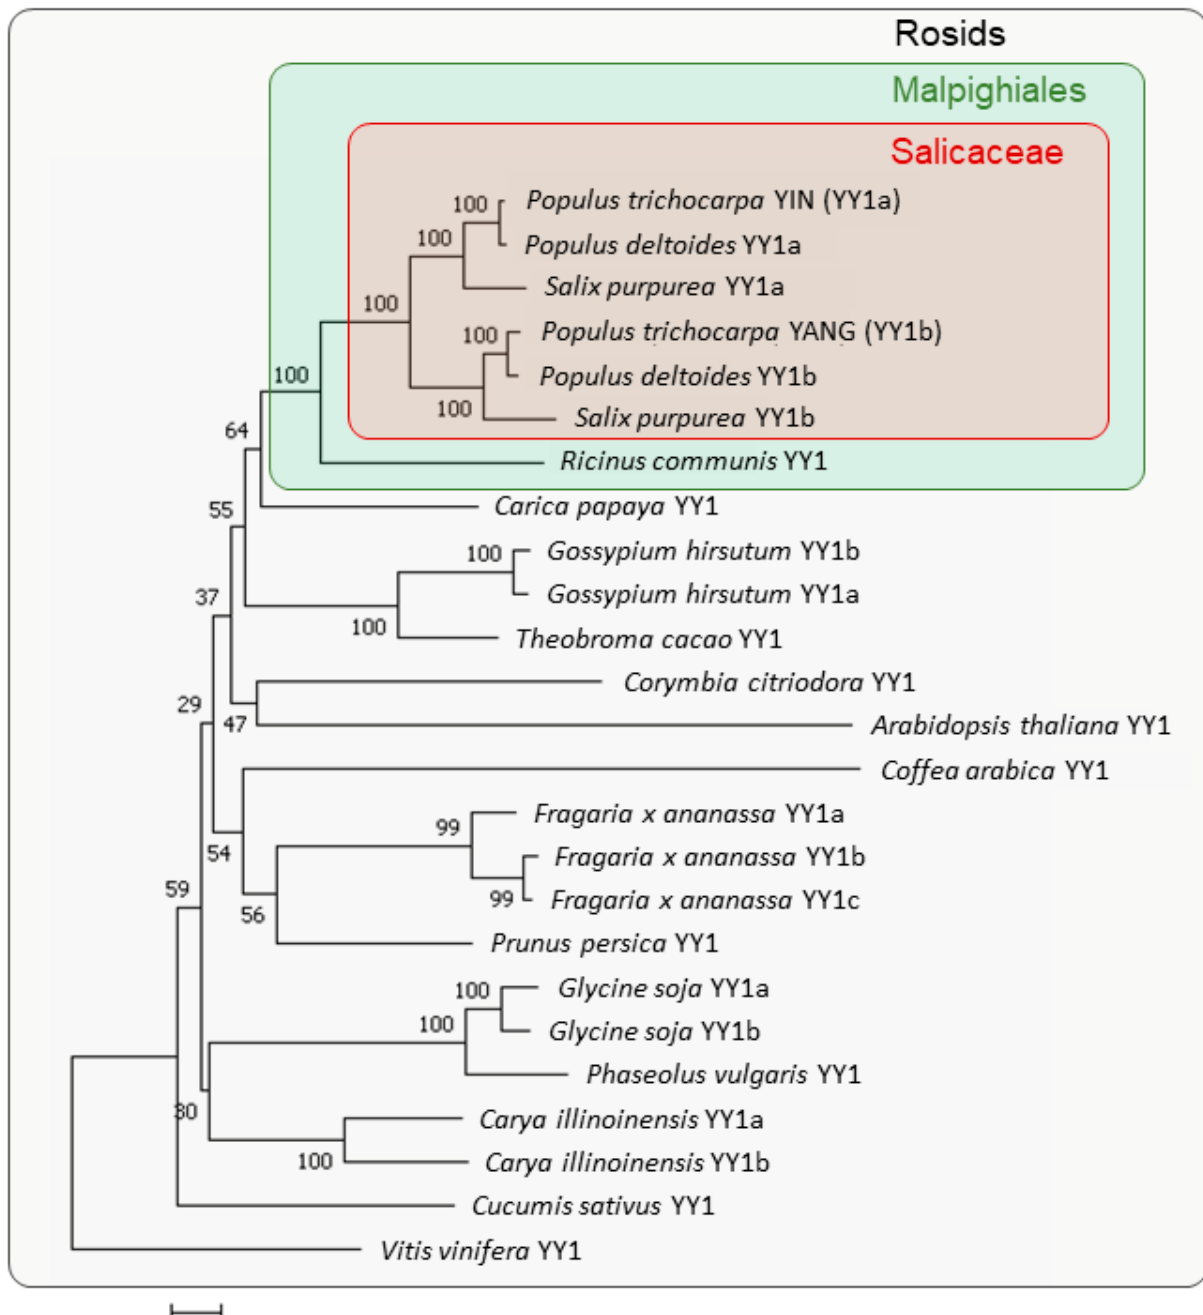
Figure 1. Phylogenetic relationship of YY1 proteins from different plant species of the Rosids clade. The phylogenetic tree constructed with 25 YY1 genes from 17 different species. The Salicaceae family is marked by a red box, while the Malpighiales clade is marked by a green box. Bootstrap support values are given at the nodes. The phylogenetic analyses were conducted with MEGA 7 using the neighbor-joining (NJ) method and 1000 repetitions of bootstrap tests. All YY1 Sequence were obtained from The Phytozome (https://phytozome-next.jgi.doe.gov, accessed on 27 May 2022 and 23 March 2023, see Section 4.2). Gene IDs with the used versions and the Phytozome Genome IDs are listed in Supplementary Table S1.